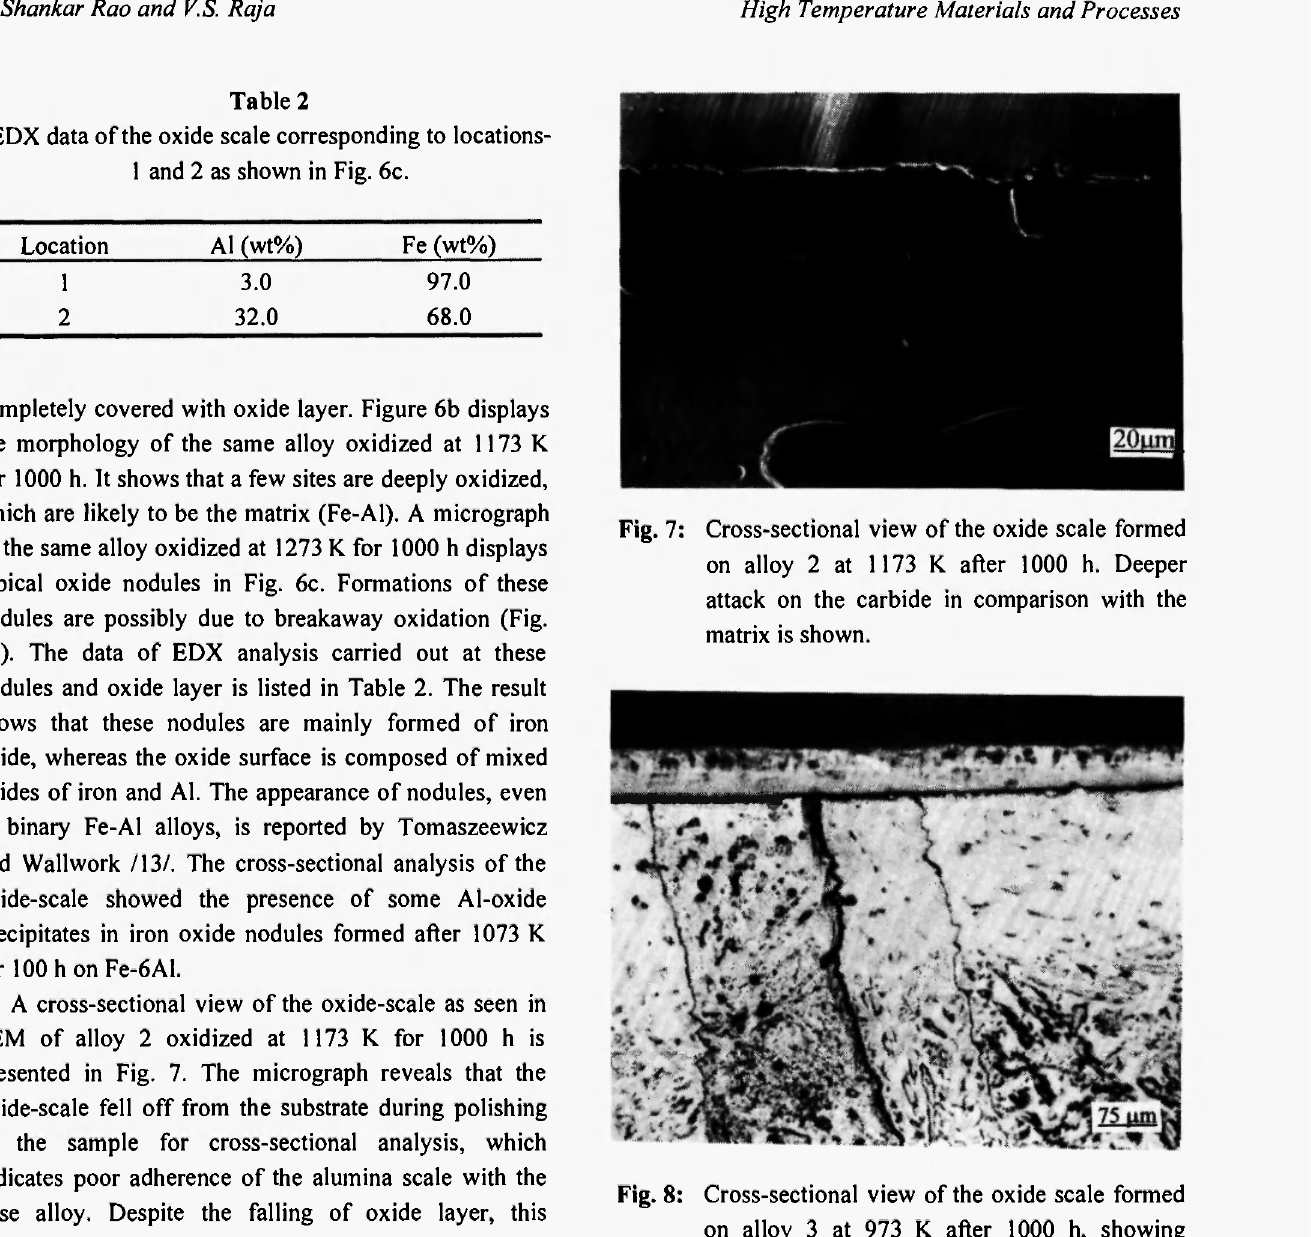
Fig. 8: Cross-sectional view of the oxide scale formed on alloy 3 at 973 Κ after 1000 h, showing formation of two layers of oxide